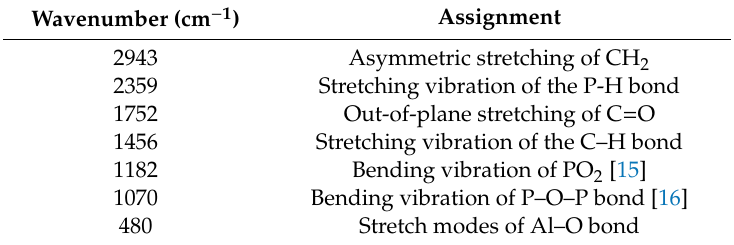
Figure 3. ( a ) Fourier transform infrared (FT-IR) spectra of PLA, BC/PLA, and BC/PLA/AHP; ( b ) X-ray photoelectron analysis (XPS) spectra of BC/PLA/AHP (25/50/25); ( c ) XPS P 2p spectra of BC/PLA/AHP (25/50/25); and ( d ) X-ray diffraction (XRD) patterns of BC/PLA/AHP after thermal decomposition. Table 5. Characteristic attribution of Fourier transform infrared (FTIR) absorption bands.